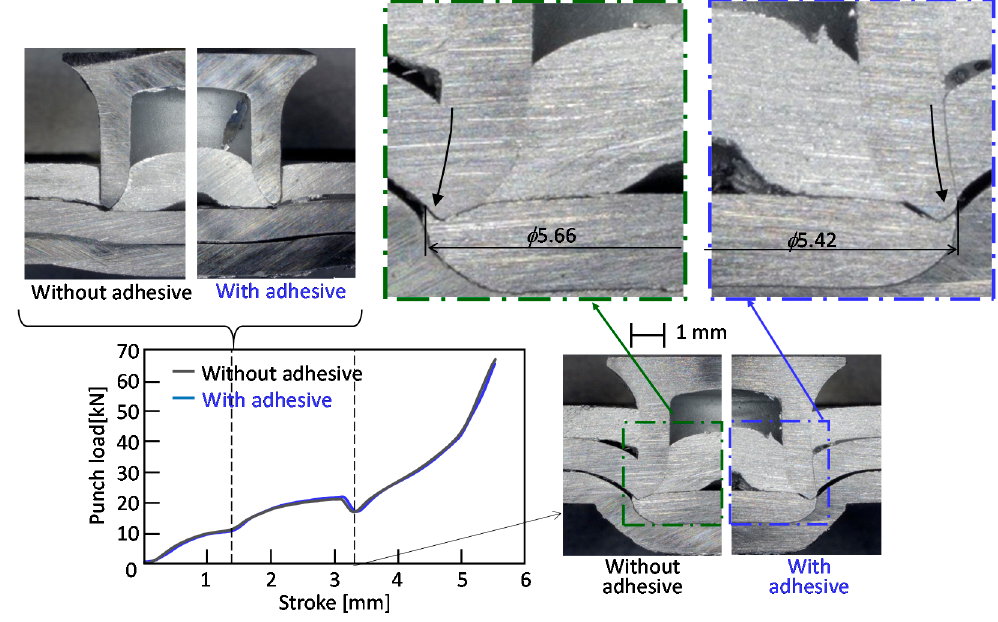
Figure 6. Deforming behaviors of sheets and rivet and punch load-stroke curves for D = 8 mm, H = 1.8 mm and L = 5 mm obtained from the experiment.